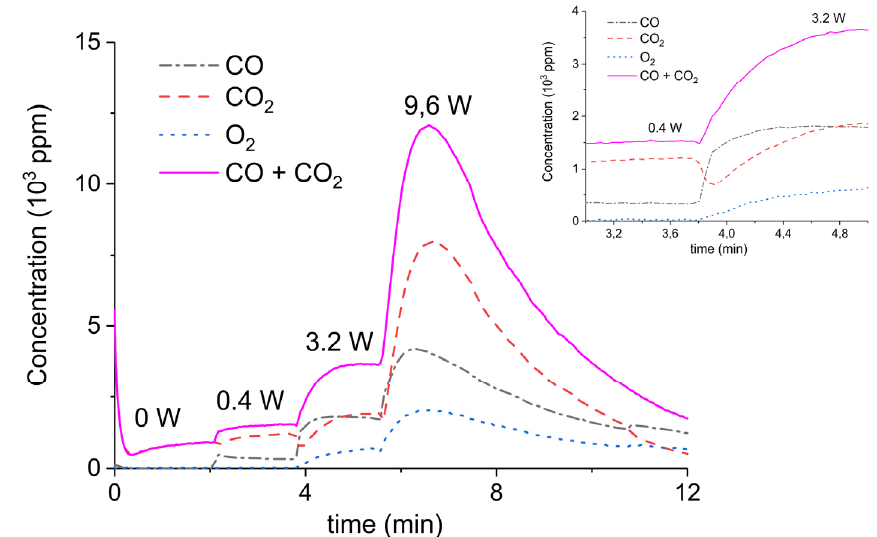
Figure 3. Concentration of the products of CaCO 3 decomposition (sample C) as function of time at 630 °C in pure argon, flow rate of 30 mL/min, plasma power is changed every 2 min with values of 0, 0.4, 3.2, and 9.6 W.